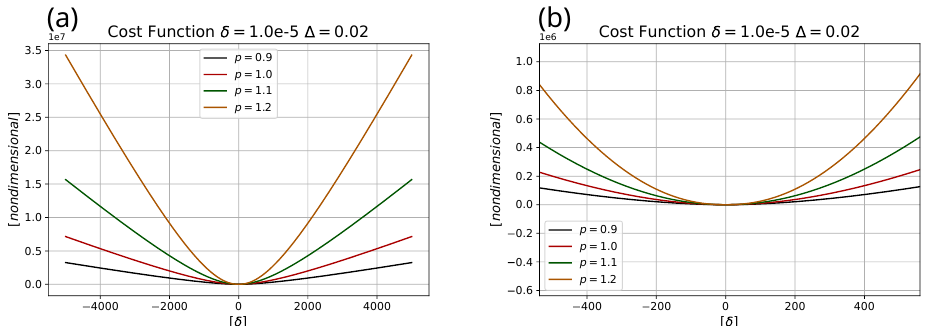
Figure 1. The schematic structure of the cost function shape for penalization (for arbitrary physical dimensions) δ = 10 − 5 , ∆ = 2000 δ , and various p values: ( a ) in full scale; ( b ) zoomed in